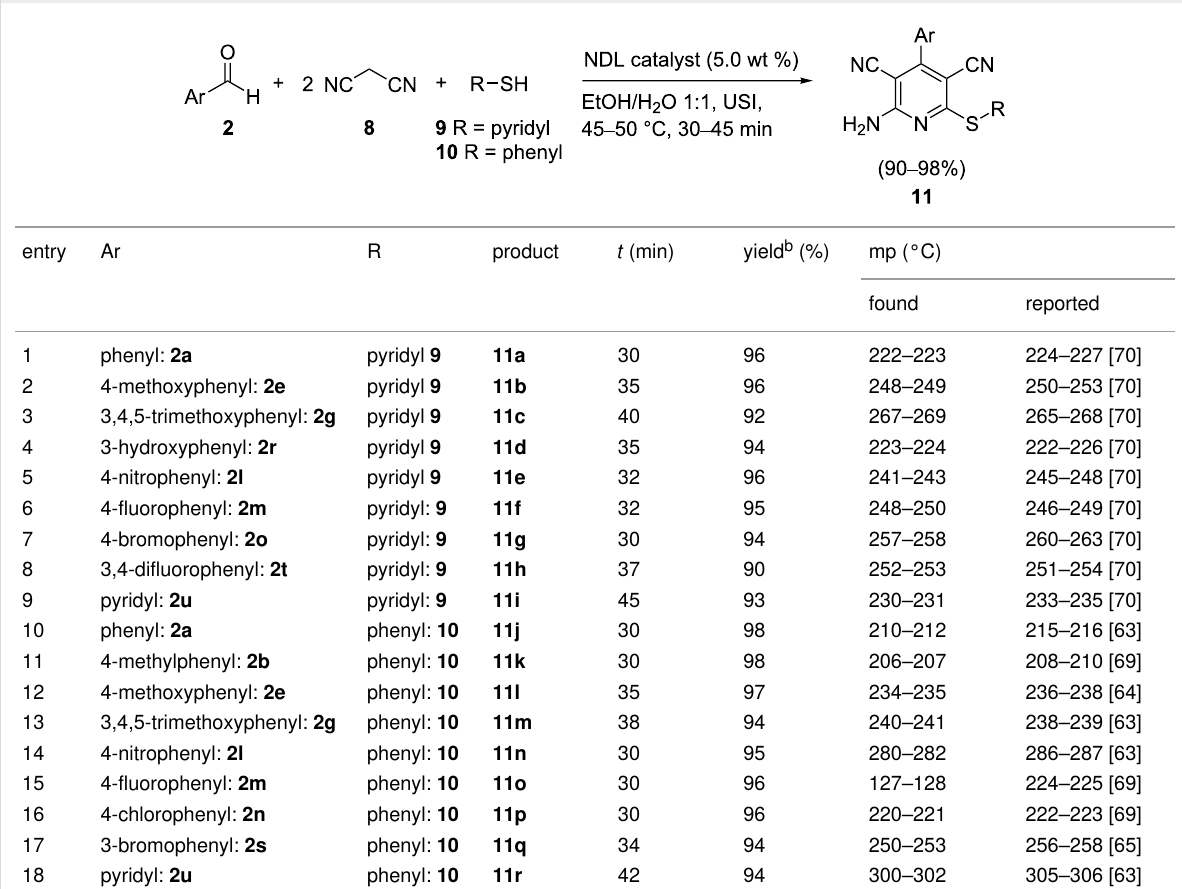
Table 7: NDL-catalyzed synthesis of 2-amino-4-(hetero)aryl-3,5-dicarbonitrile-6-sulfanylpyridines 11 .